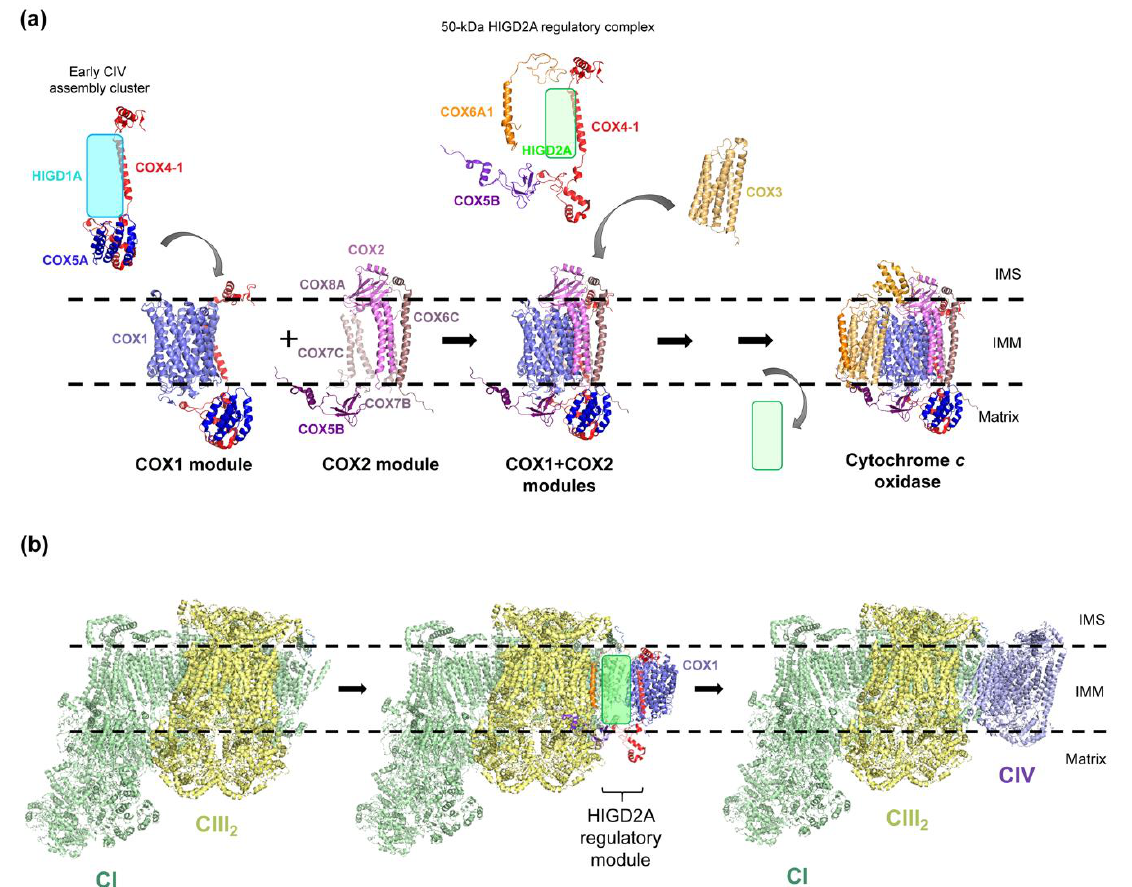
Figure 3. Roles of HIGD1A and HIGD2A in cytochrome c oxidase assembly. ( a ) Schematic view of the mammalian modular cytochrome c oxidase assembly pathway. HIGD1A is present in an early assembly cluster, together with the COX1 module proteins COX4-1 and COX5A. HIGD2A forms a 50 kDa regulatory module with COX4-1, COX5B, and COX6A1, which binds to newly synthesized COX3 to promote its binding to the previously assembled COX1 + COX2 module. HIGD1A and HIGD2A are represented by a blue and a green box, respectively, due to the lack of structural information. ( b ) The HIGD2A regulatory module plays a role in supercomplexed cytochrome c oxidase assembly, by interacting with SC I + III 2 and facilitating the incorporation of the remaining CIV subunits. The figure was generated with PyMOL and Adobe Photoshop using the structure of the CI-CIII 2 -CIV respirasome from ovine heart mitochondria [81] (PDB 5J4Z). IMS: intermembrane space. IMM: inner